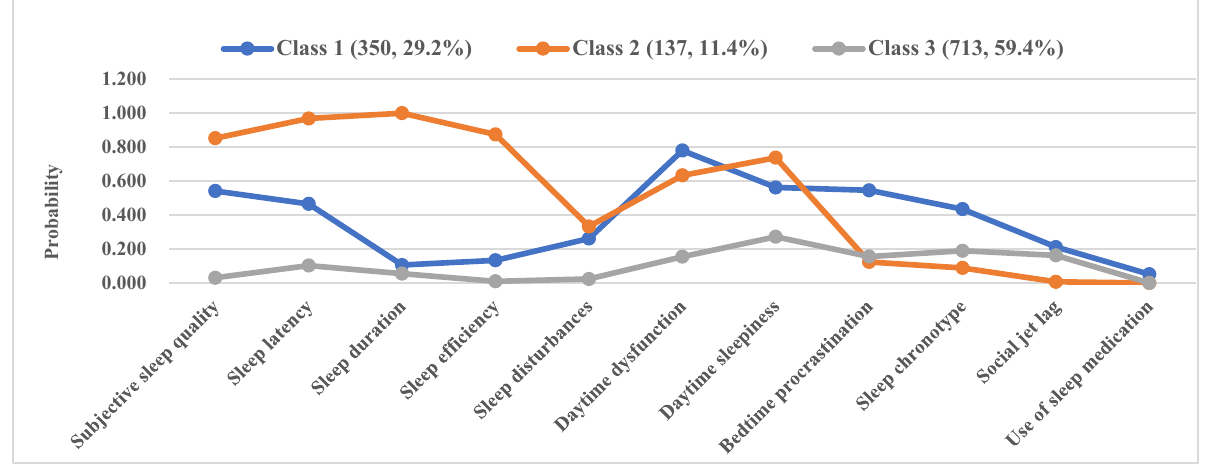
Figure 1. Graphical representation of the latent classes of sleep patterns.